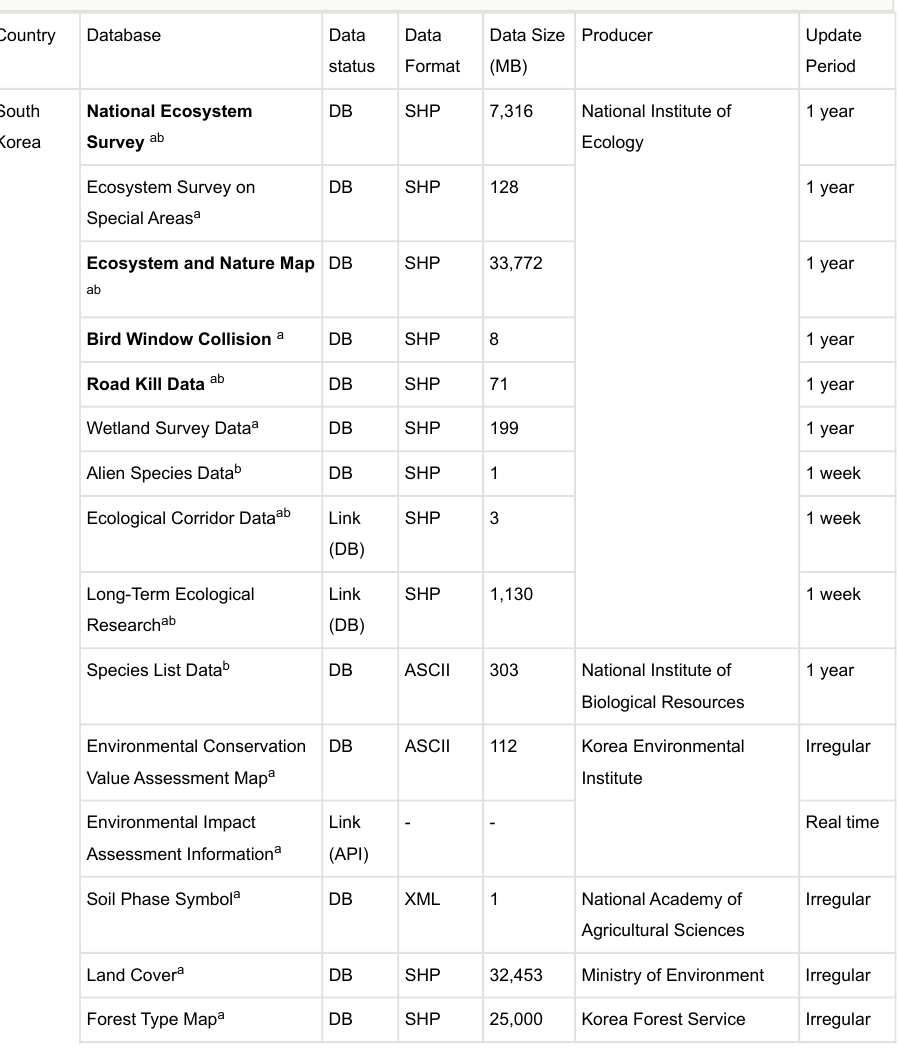
resolution and more up-to-date spatial information of Vworld maps compared to Google Maps.